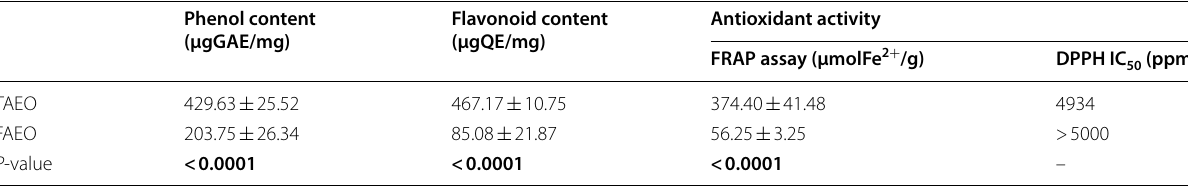
The P-value lower than 0.05 (P <0.05) was considered as significant